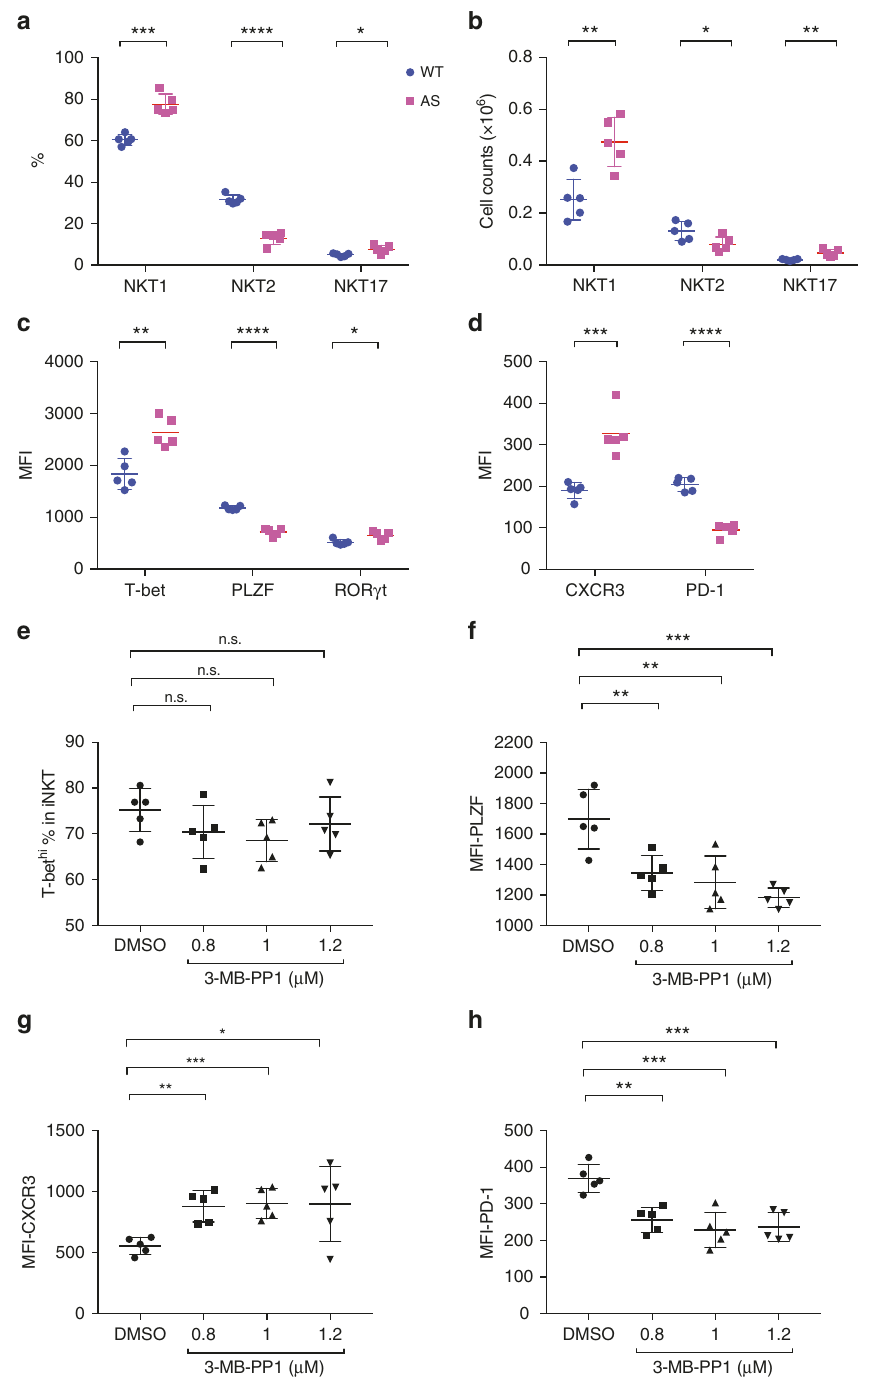
Fig. 3 NKT1 skewing phenotype in ZAP70AS mice. a , b Percentages in total iNKT cells and absolute numbers of iNKT cell subsets in ZAP70AS and control mice. c , d Expression of lineage de fi ning transcription factors and some subset surface markers. e – h Day 0 thymic lobes from ZAP70AS mice were cultured as in Fig. 2. Different doses of the inhibitor 3-MB-PP1were added on the second day of culture, and iNKT cells were examined on day 7 for expression of the indicated proteins. Data are representative of three independent experiments. Graphs represent mean ± SD with symbols representing individual mice ( a – d ) or thymic lobes ( e – h ). * p < 0.05; ** p < 0.01; *** p < 0.001; **** p < 0.0001; n.s. not signi fi cant (unpaired two-tailed Student ’ s t